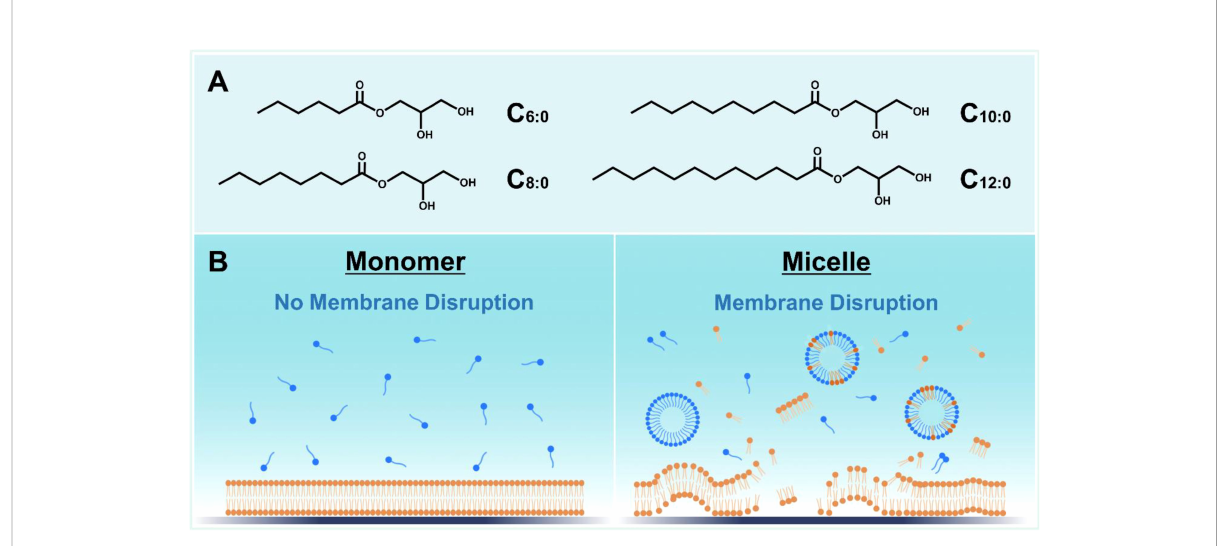
FIGURE 1 Overview of medium-chain monoglyceride (MCMG) structure and function. (A) Chemical structures of MCMG with saturated chains. (B) Schematic illustration depicting how MCMG in micellar form can disrupt phospholipid membranes such as those of bacteria and enveloped viruses while MCMG in monomeric form are largely